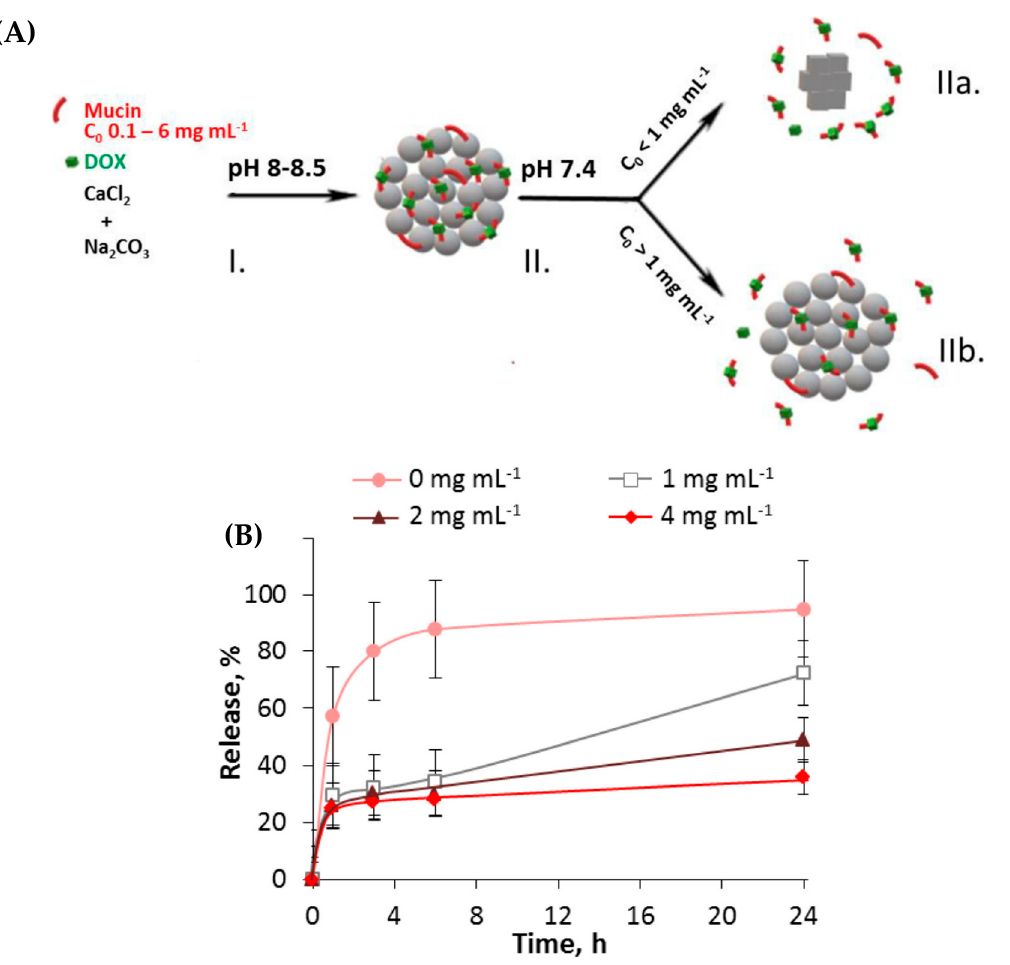
Figure 8. ( A ) Schematic illustration of (I) the co-synthesis of CaCO 3 -mucin hybrid crystals containing DOX and (II) the release of DOX at physiological conditions via diffusion of mucin-DOX complexes outwards due to re-crystallization of the CaCO 3 crystals to calcite (IIa) and the complex diffusion out of the pores of the vaterite crystals (IIb). ( B ) The kinetics of DOX release from CaCO 3 -mucin-DOX hybrids at different mucin concentrations during co-synthesis. Figures taken with permission from Reference [80], copyright © 2019, Elsevier.